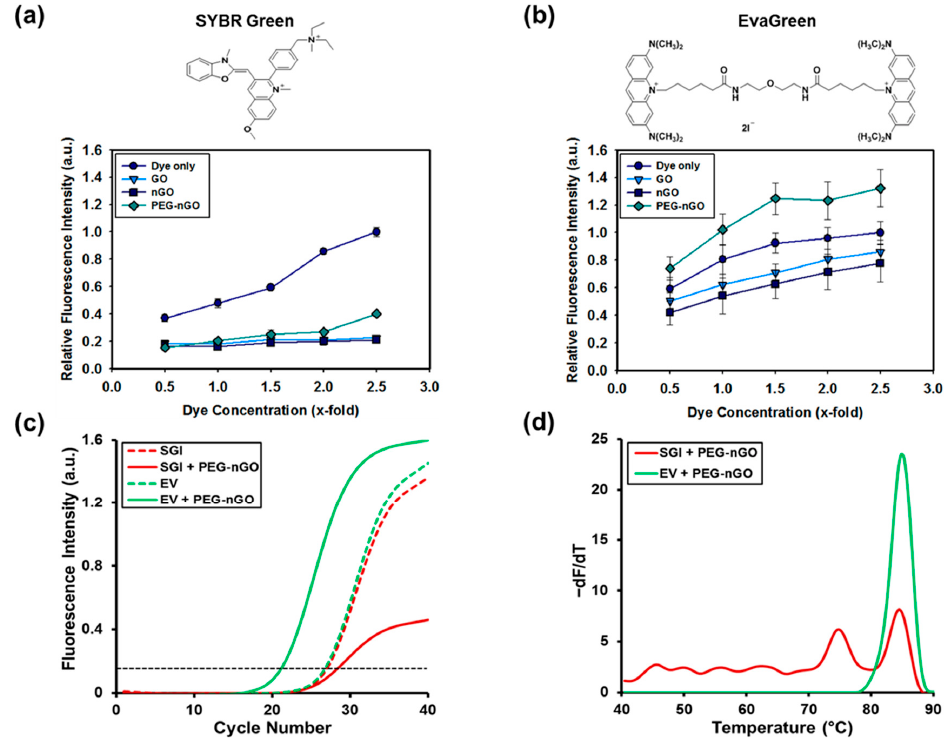
Figure 1. Effect of dsDNA-binding fluorescent dyes on PENGO-qPCR. ( a ) Chemical structure of SYBR Green I (SGI) dye (top panel) and fluorescence intensities of various SGI dye concentrations (0.5-, 1-, 1.5-, 2-, and 2.5-fold) incubated with Plasmid DNA and GO, nGO or PEG-nGO (1 μ g mL − 1 ), measured at 485 nm and 535 nm as excitation and emission wavelength, respectively. ( b ) Chemical structure of Eva Green (EG) dye (top panel) and fluorescence intensities of various EG dye concentrations (0.5-, 1-, 1.5-, 2-, and 2.5-fold) incubated with plasmid DNA and GO, nGO or PEG-nGO (1 μ g mL − 1 ), measured at an excitation wavelength of 485 nm and emission wavelength of 535 nm. ( c ) Real-time fluorescence monitoring of target (IFZ B) RNA amplification with SGI dye and EG dye in the presence or absence of PEG-nGO. The cycle threshold (Ct), shown as a horizontal dotted line, is the cycle at which 10% of the maximum amplified fluorescence intensity was employed for signal quantification. ( d ) Melting curve analysis of qPCR-amplified target RNA with SGI dye and EG dye in the presence of PEG-nGO. Melting temperatures (T m ) were determined from plots of the negative fi rst derivative of change in fl uorescence with temperature versus temperature ( − dF/dT vs. T) .